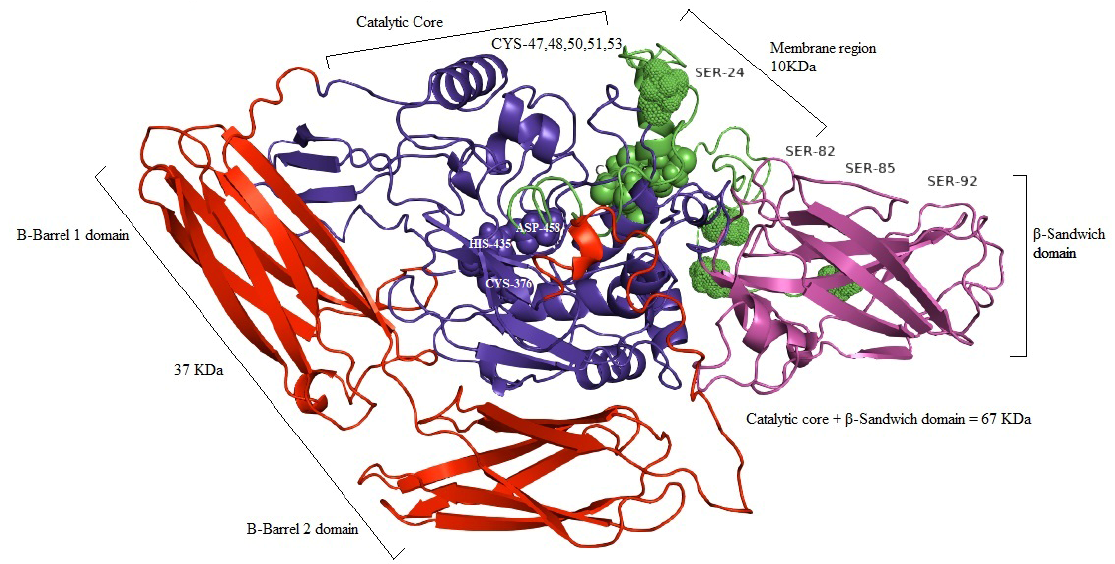
Figure 3. Predicted 3D model of TGase1 enzyme in Ribbon. Figure shows four main structural domains with 37Kda, B-barrel 1, and B-Barrel 2 domain in red, and 67KDa B-Sandwich domain in magenta and catalytic core domain in blue. The 10 Kda membrane anchorage part is indicated in green with SER-24, SER 82, SER-85, and SER-92; the phosphorylation sites are represented in dot, CYS-47, CYS-48, CYS-50, CYS-51, CYS-43; the proposed site of acylation is represented in spheres. The catalytic triad CYS-376, HIS-435, and ASP-458 is mentioned within catalytic core.